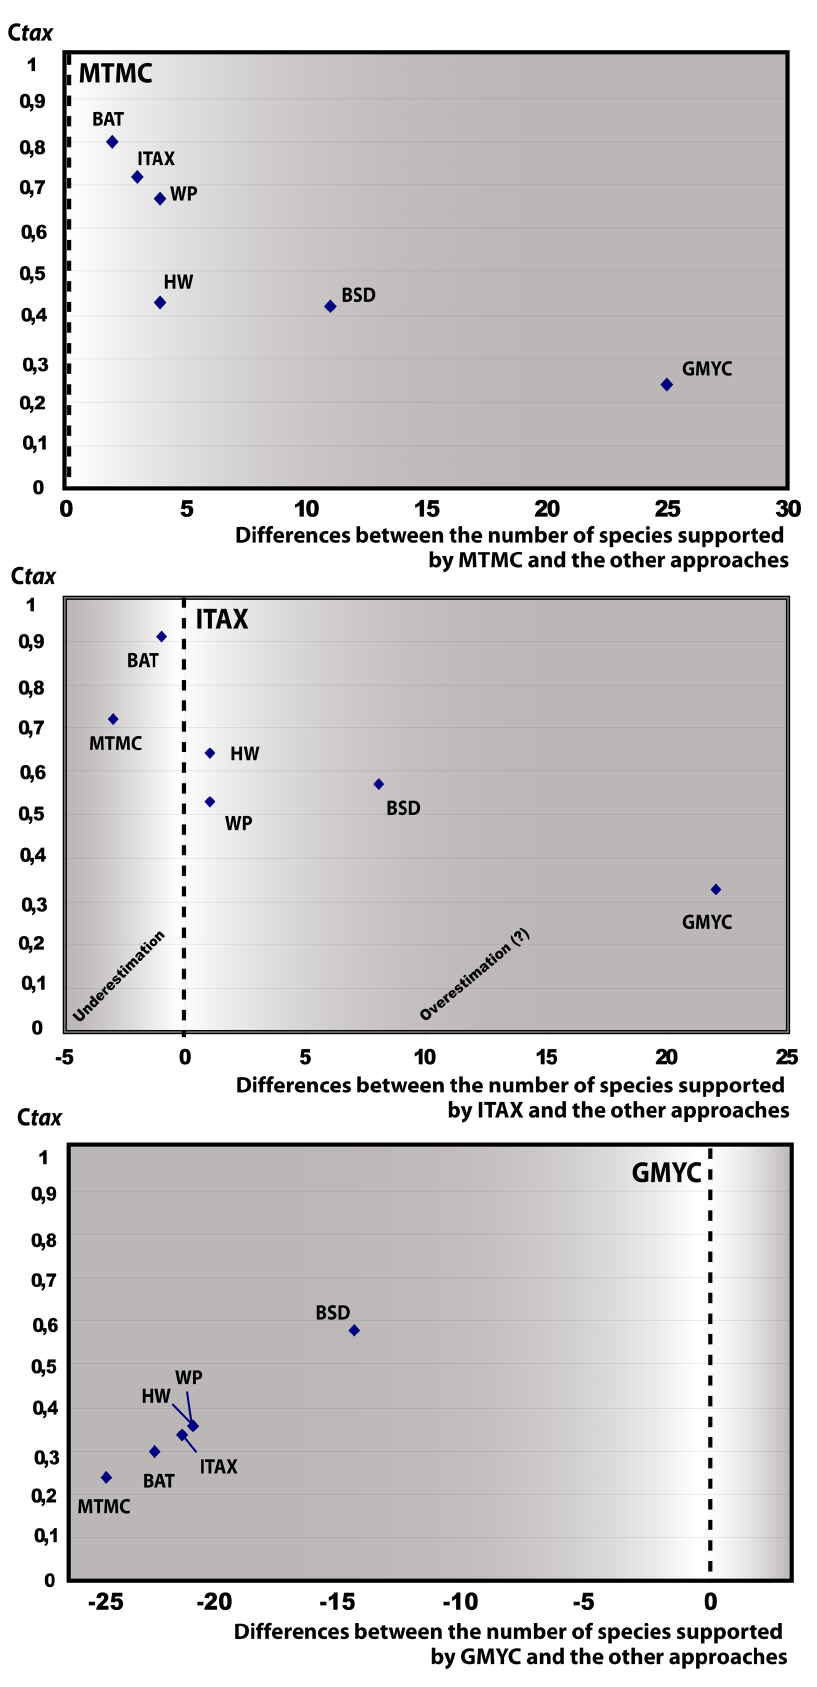
New Metrics for Comparison of Taxonomies